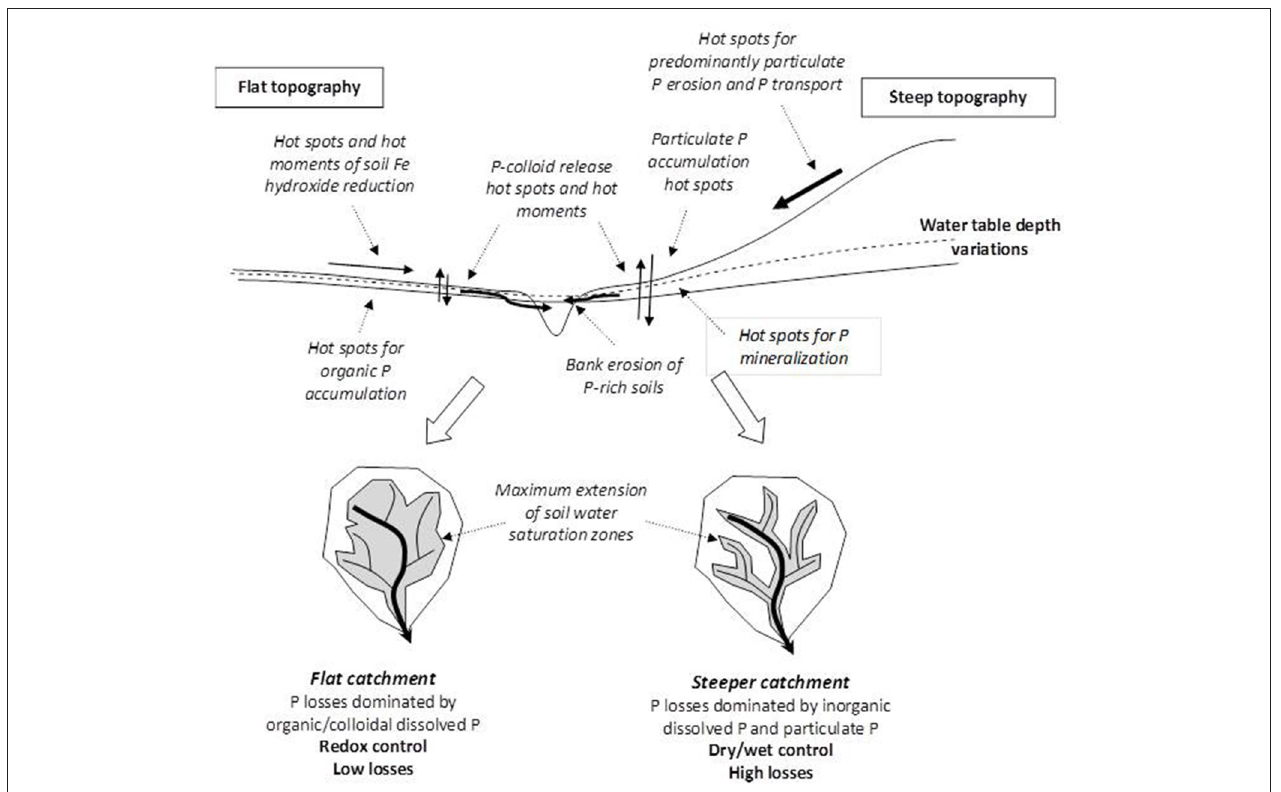
FIGURE 3 | Sketch illustrating the concept of landscape biogeochemistry applied to dissolved, colloidal and particulate P emissions in catchments (adapted from Gu et al., 2017).